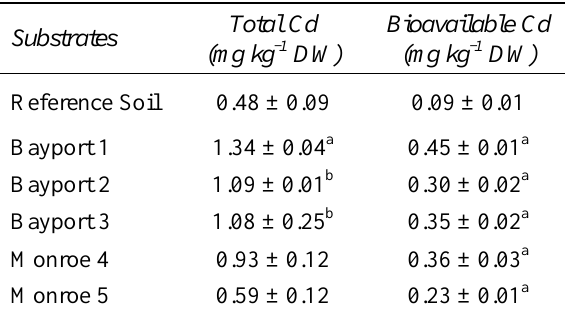
Table 5: Total and bioavailable cadmium concentrations (mean values and standard error,